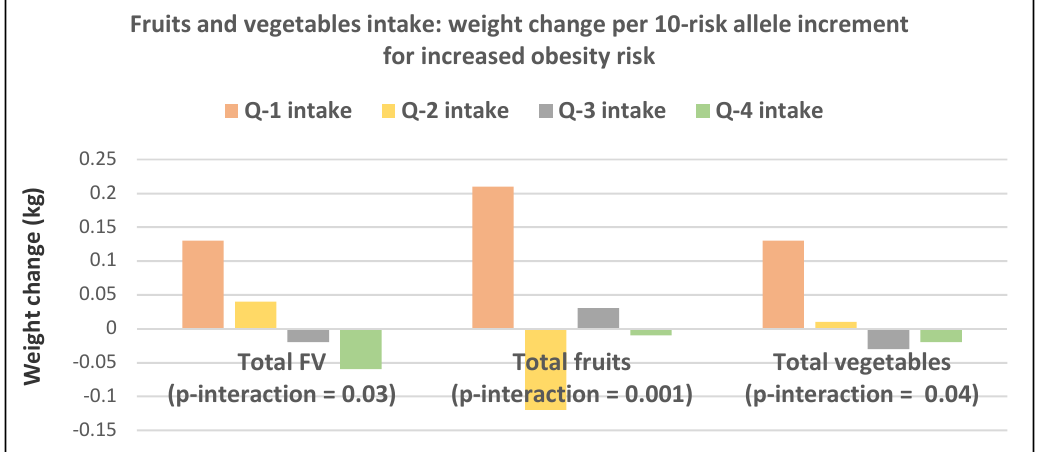
Figure 7. Multivariate adjusted weight change over 4-years per 10 allele increment of genetic susceptibility to obesity for each quintile (Q) of total fruit and vegetable (FV) intake by 8943 middle-aged, overweight women from the Nurses’ Health Study [25].